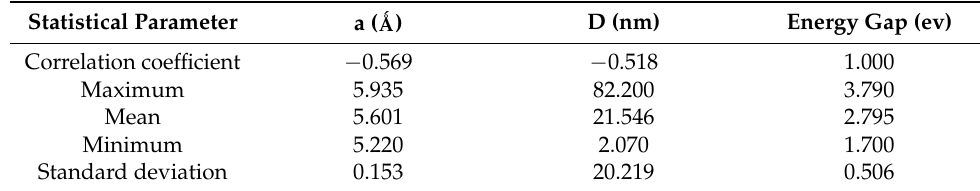
Table 1. Description of statistical analysis results.